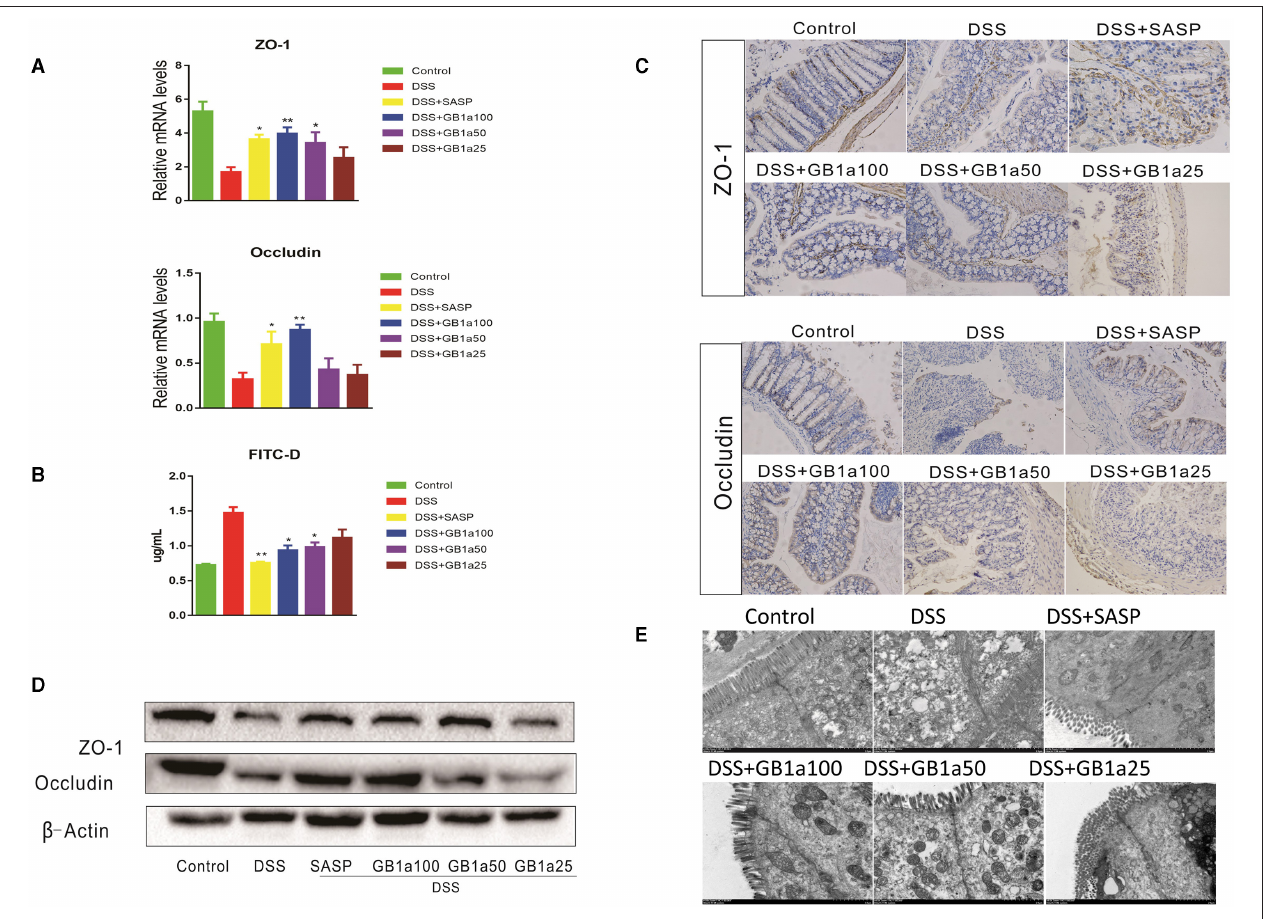
FIGURE 6 | The protective effect of GB1a on the intestinal mucosa (A) GB1a treatment upregulated the expression of genes ZO-1 and Occludin. (B) GB1a administration reduced the levels of fluorescein isothiocyanate (FITC)-dextran in the serum of UC mice and improved mucosal permeability in the colon. (C) Representative images of immunohistochemical staining of ZO-1 and Occludin and Claudin2 in mouse colon sections. (D,E) Ultrastructural morphology of the intestinal mucosal barrier. Data are presented as means ± SD ( n = 7/group). * p < 0.05 and ** p < 0.01. vs the DSS-incubated